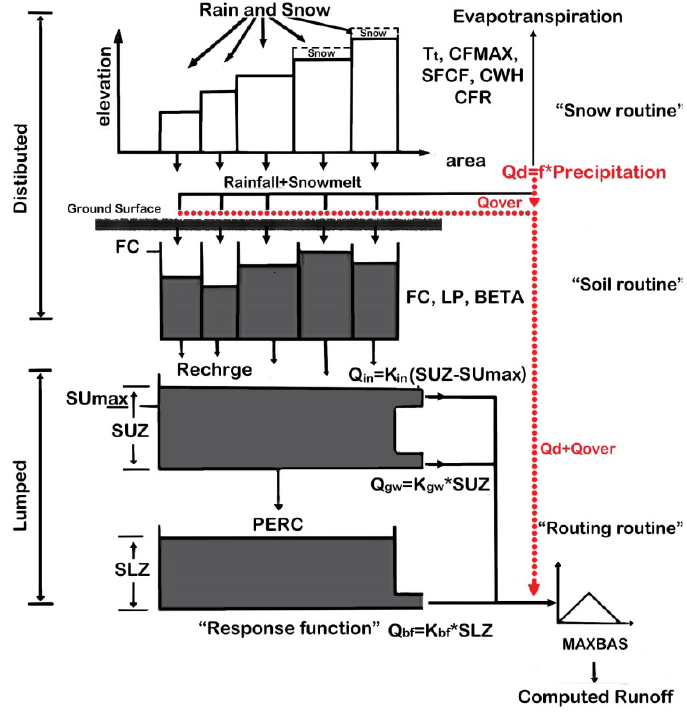
Figure 1. Improved HBV (IHBV) diagram.